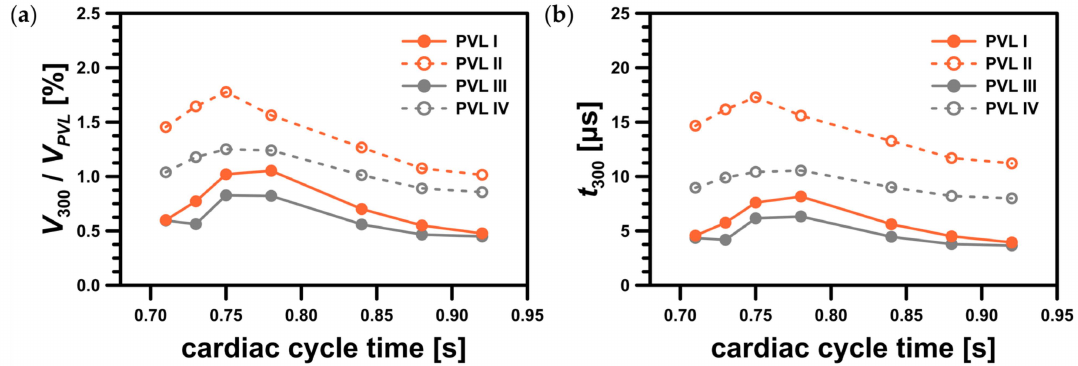
Figure 11. Characteristics of region with shear stress value greater than 300 Pa: ( a ) ratio of the region volume, V 300 , to the PVL volume, V PVL ; ( b ) residence time in the region, t 300